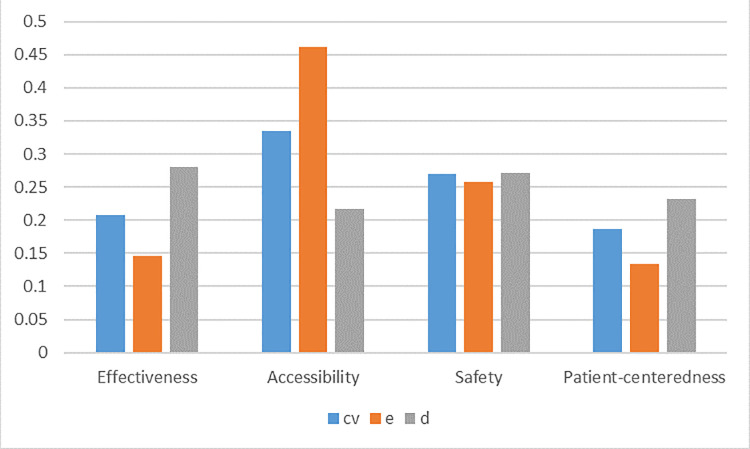
Criteria weights.